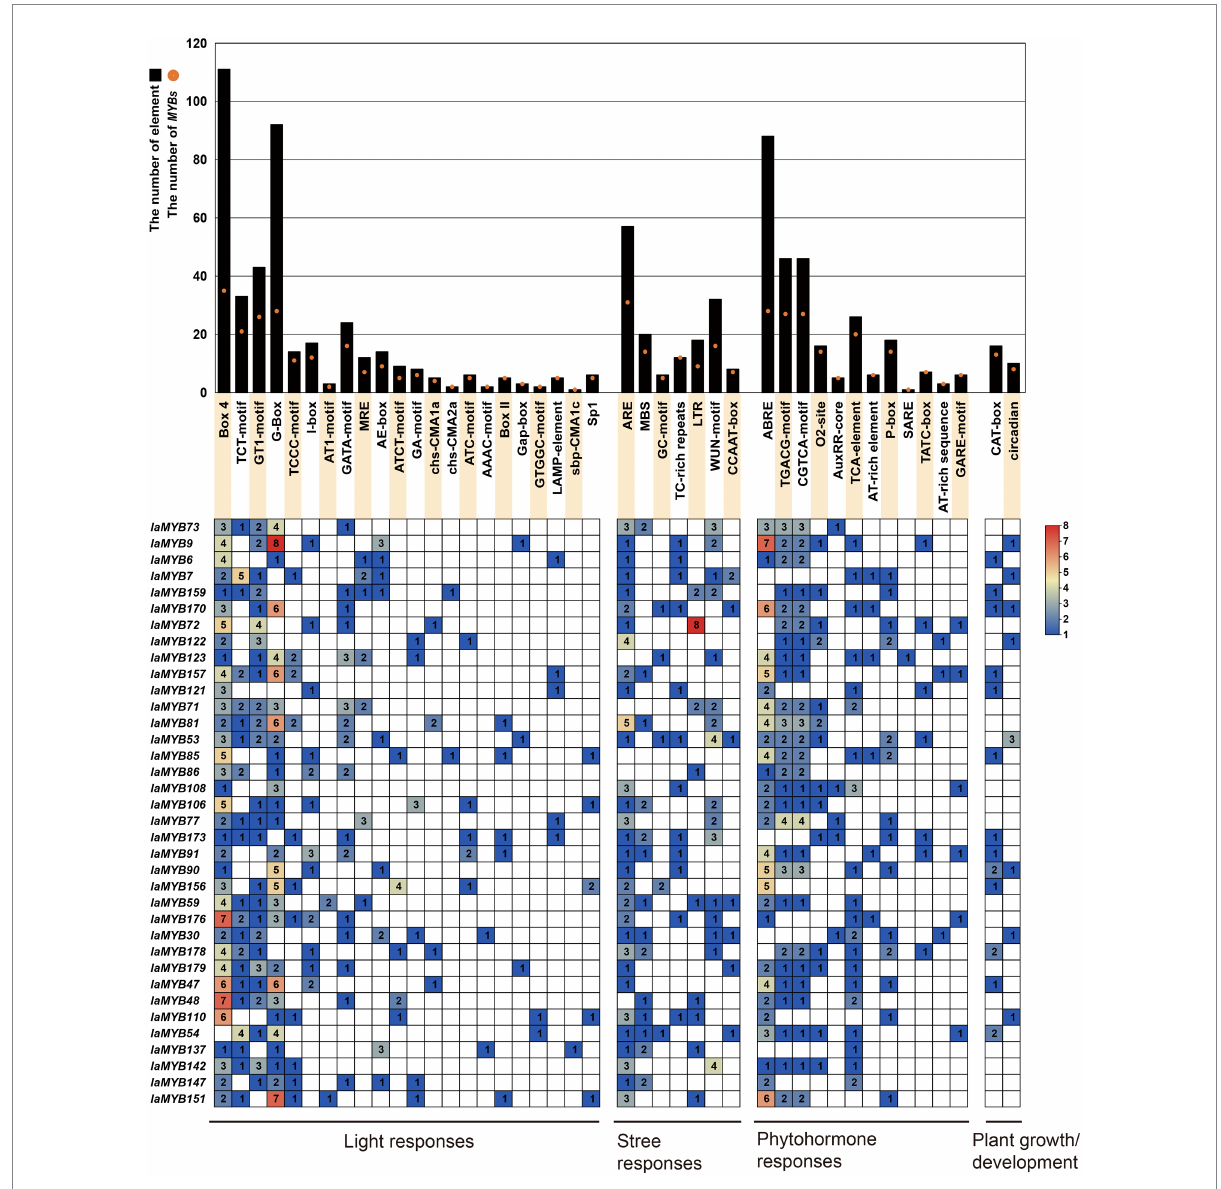
FIGURE 8 Cis -acting elements in the promoter region of the 36 DEGs. The histograms show the total number of the corresponding cis -acting elements in the promoter region of each DEG, whereas the orange dots show the total number of the DEGs containing the corresponding cis -acting elements. The heatmap was generated based on the number of the corresponding cis -acting elements in the promoter region of each